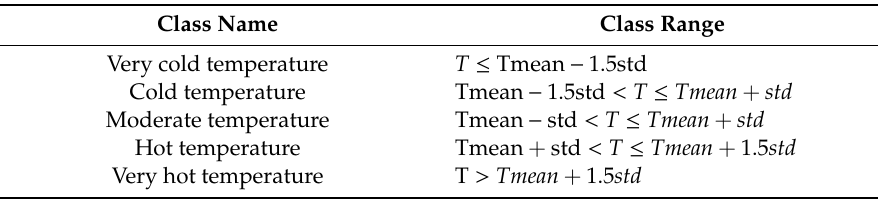
Table 2. LST classification of the studied images